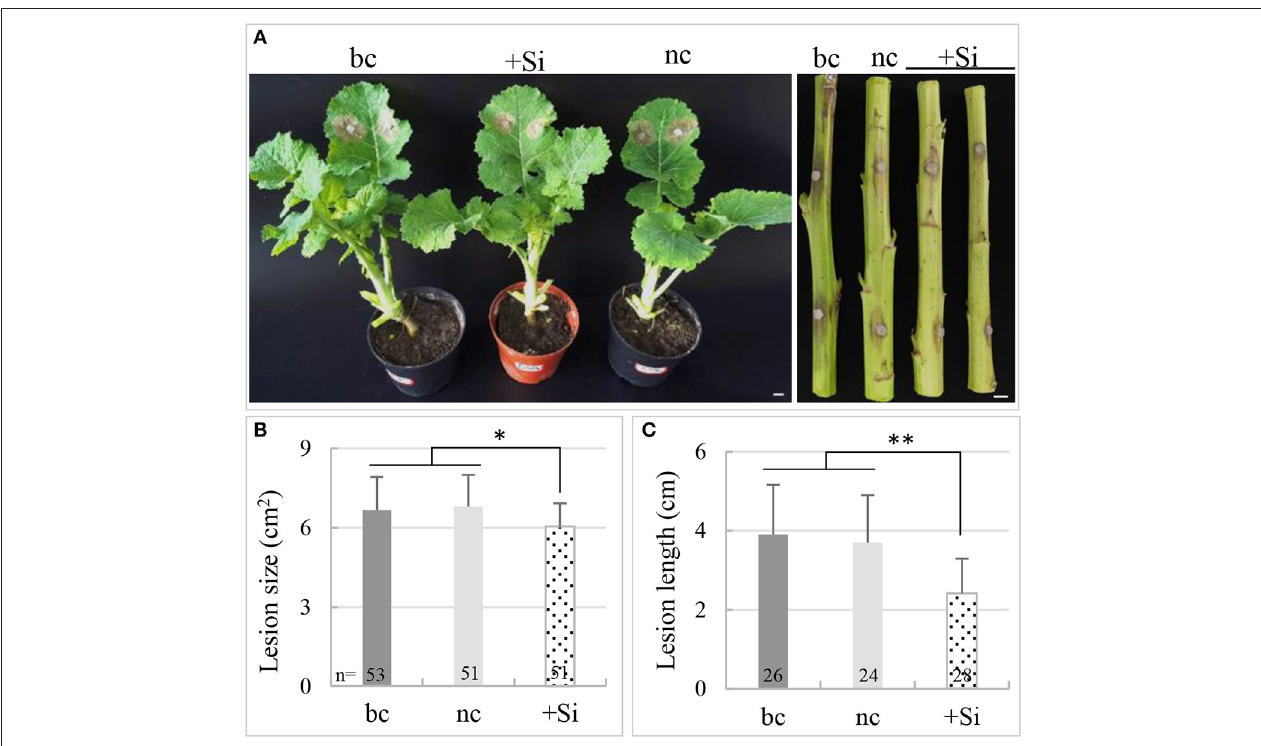
FIGURE 2 | Effects of the silicon (Si) fertilizer on plant resistance to S. sclerotiorum in a pot assay. (A) Disease symptoms of inoculated rapeseed under + Si treatment (Si fertilizer), potassium sulfate fertilizer treatment (the negative control, nc), and the black control (bc). Bars = 1cm. (B) Comparison of lesion size on the inoculated leaves of rapeseed among treatments. (C) Comparison of lesion length on the inoculated stems of rapeseed among treatments. The number on the bottom of each bar of B and C represent the number of samples tested. * and ** indicate significant differences at the p < 0.05 and p < 0.001 levels,